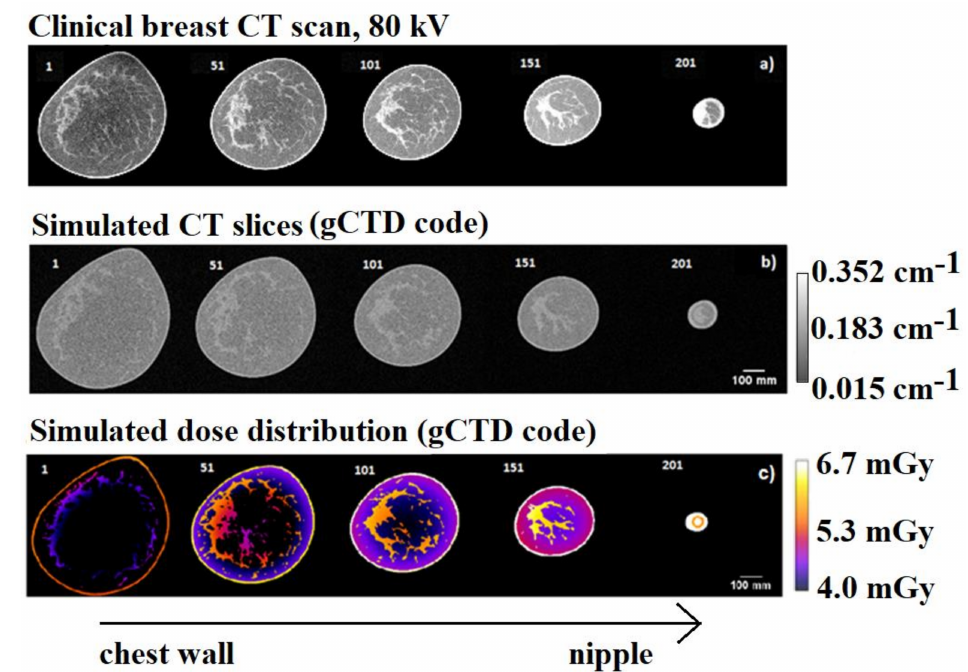
Figure 9. Example axial slices (#1 to #201) of ( a ) clinical breast CT scan at 80 kV and ( b ) simulated CT- reconstructed slices (FDK algorithm) that were obtained using the gCTD simulation code. In ( c ) are the reported calculated dose distributions in the corresponding